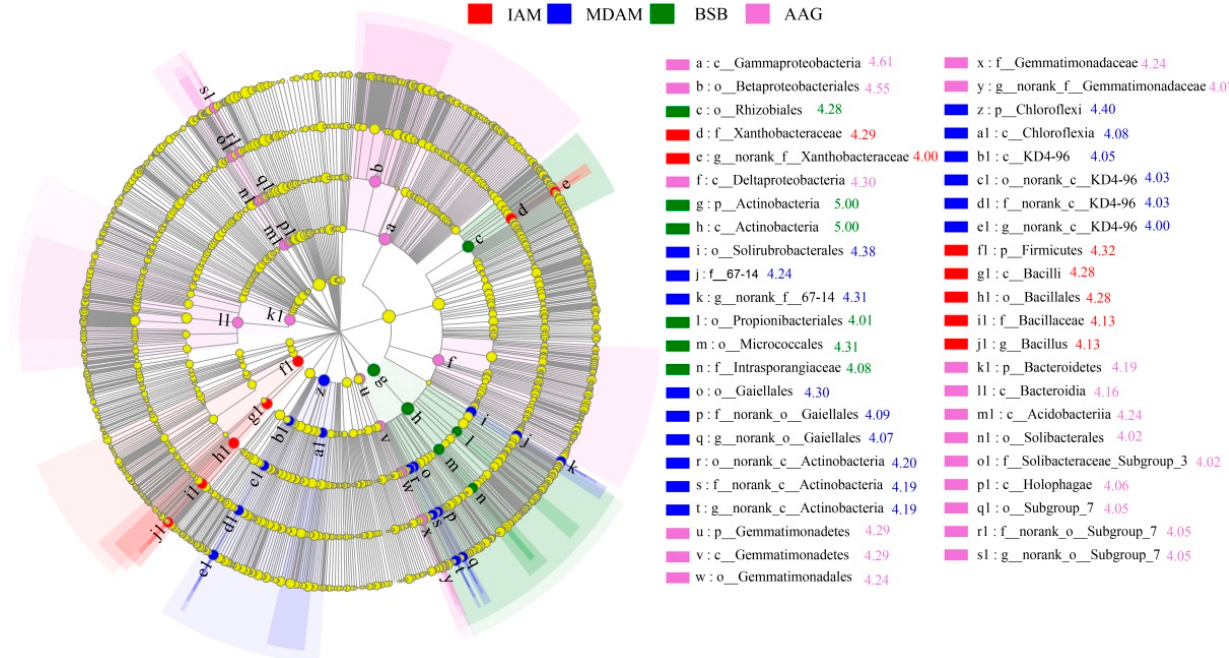
Figure 4. Linear discriminant analysis effect size (LEfSe) analysis of microbial abundance in different types of alpine meadow, identified with a threshold value of 4.0. The LDA scores are listed after the legend. IAM, intact alpine meadow; MDAM, moderately degraded alpine meadow; BSB, black soil beach; AAG, artificial grassland. Table 2. Distribution of total bacteria, unique, and common in different groups.